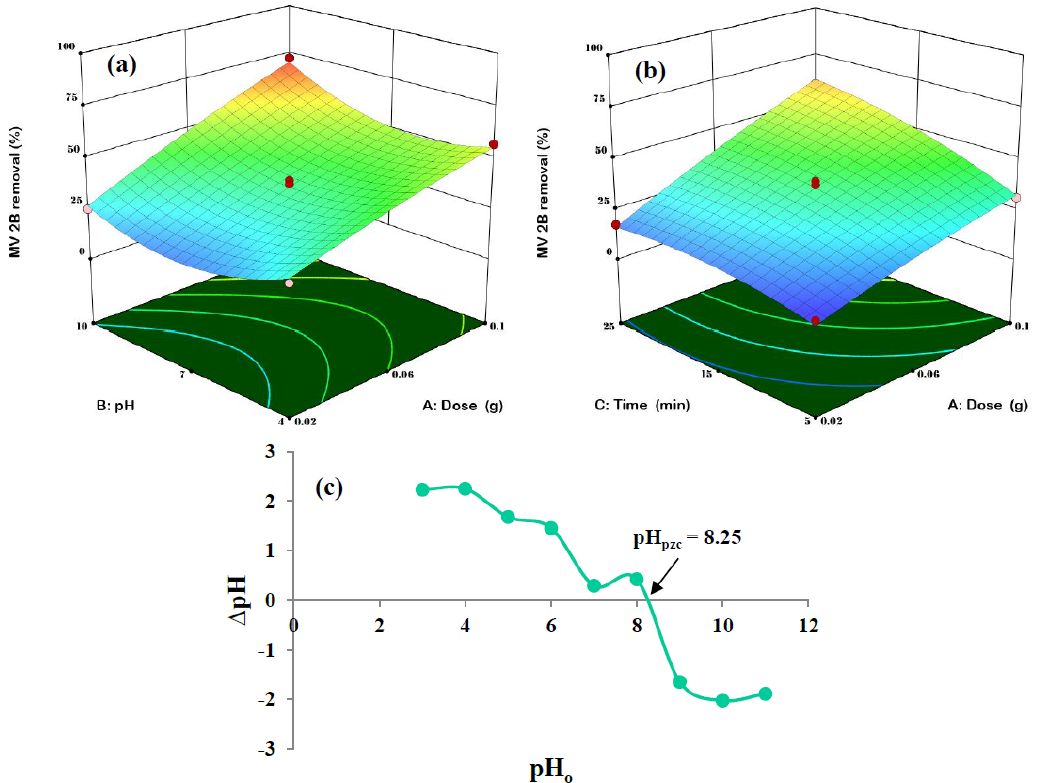
Figure 5. 3D plots of MV 2B removal showing ( a ) AB and ( b ) AC interactions, while ( c ) pHpzc of MCAC.